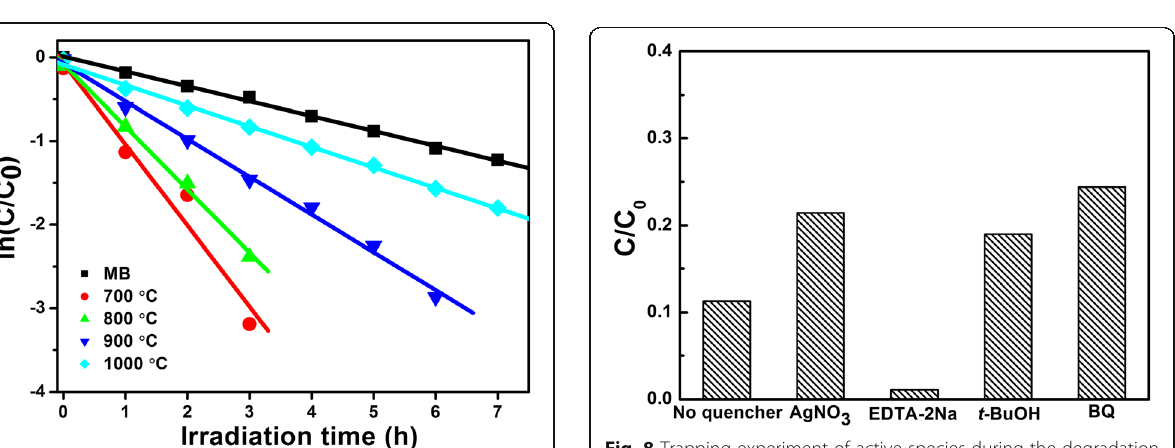
Fig. 8 Trapping experiment of active species during the degradation of MB under UV light irradiation with the presence of LiNb 3 O 8